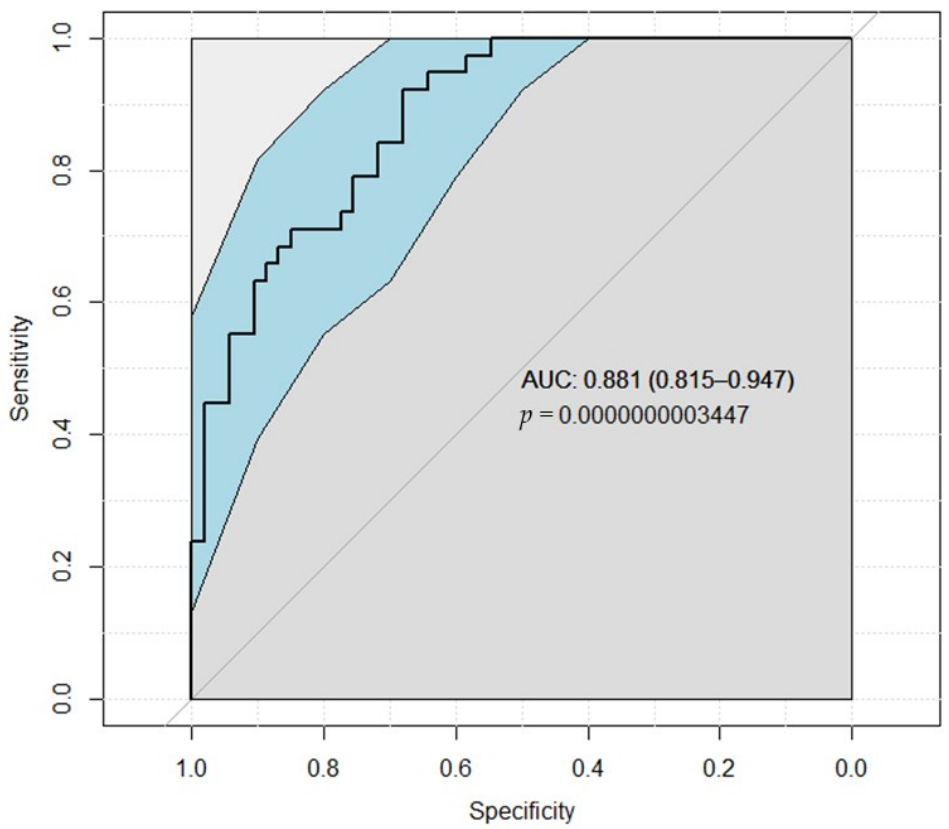
Figure 3. ROC analysis result for neutrophil to lymphocyte ratio and intraoperative hypotension detecting AKI. Abbreviations: AUC − area under the curve.